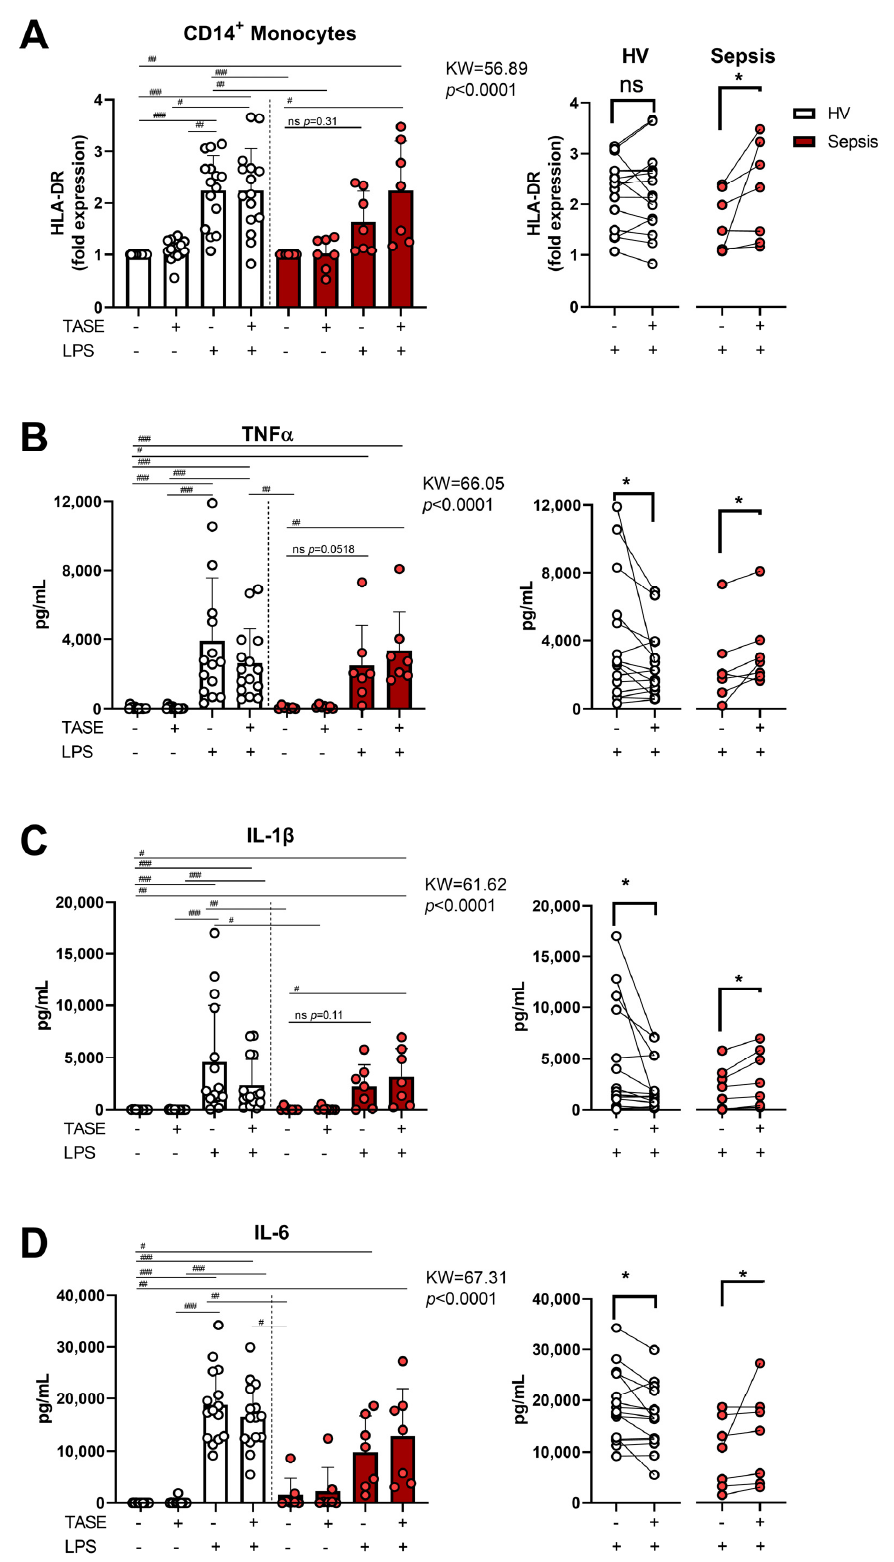
Figure 2. Effects of thiosulfinate-enriched Allium sativum extract (TASE) in LPS response of monocytes from both HV and septic patients. ( A ) Monocytes from HV ( n = 15) and septic patients ( n = 7)